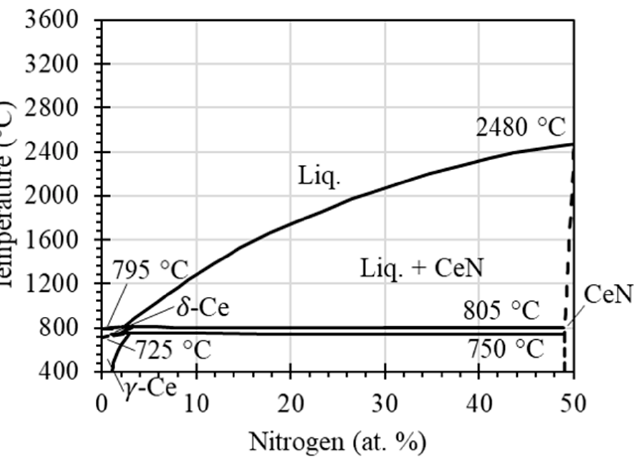
Figure 7. Equilibrium phase diagram of Ce-N, adapted from the literature (Gschneidener and Verkade, 1975,